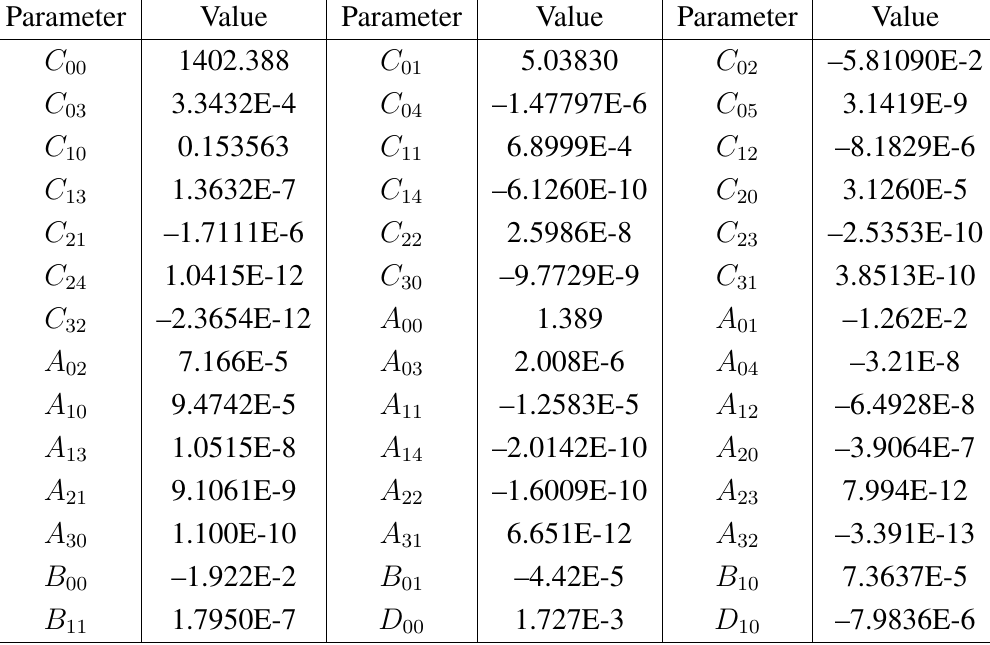
Table 1. Parameters for calculating the Chen–Millero equation